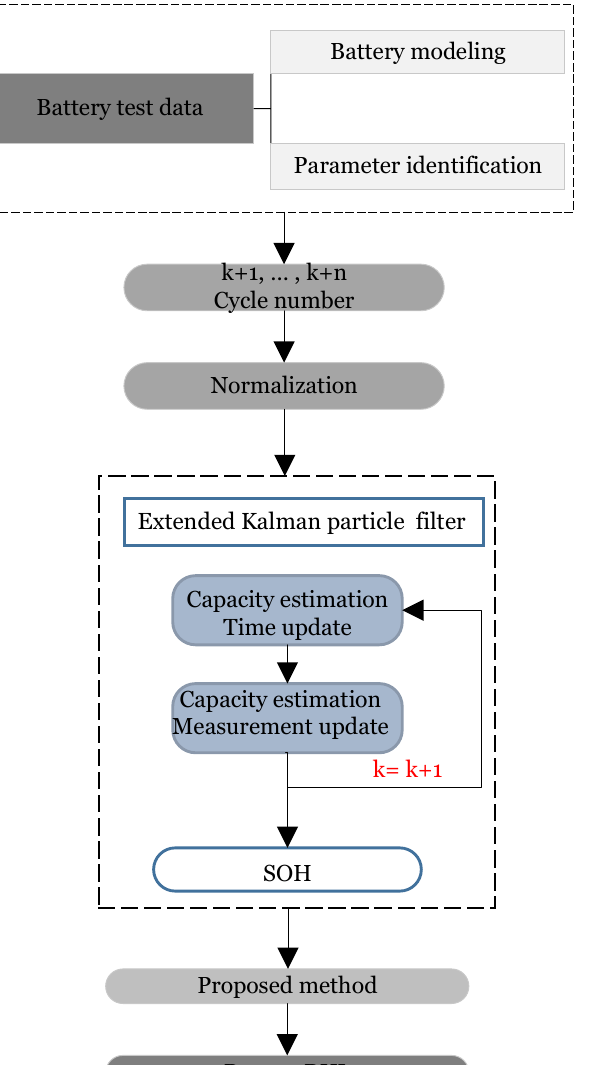
Figure 3. Flow diagram of EKPF